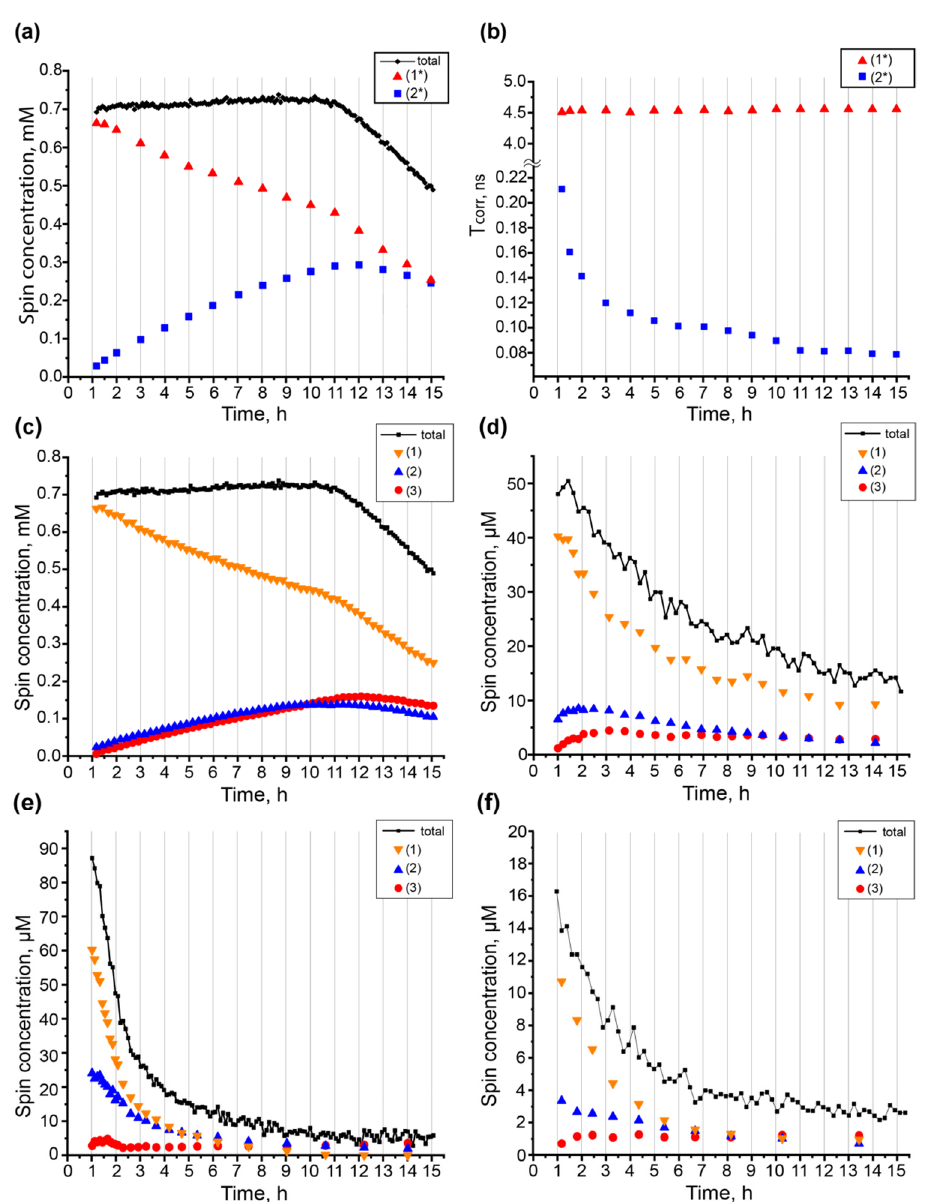
Figure 8. Second-integral decay kinetics and individual-component kinetics of the EPR spectra of A549 cells incubated with ( a , c ) 5.5 μ M, ( d ) 0.5 μ M sRL2 (molar ratio of spin label 1 to RL2 2 : 4) or with 1.34 μ M sRL2 (molar ratio of spin label 1 to RL2 2 : 3.5) without ( e ) or with ( f ) the addition of 1% of NaN 3 . ( b ) Time-dependent change of rotational correlation times for EPR spectral components in the case when simulations involve only two components. The time is counted from the end of the cell incubation with sRL2. Black: the total second integral of EPR spectra. ( a , b ) Red triangles and blue squares correspond to EPR spectral component 1* and component 2*. ( c – f ) Orange inverted triangles, blue triangles, and red circles correspond to EPR spectral component 1, component 2, and component 3, respectively. When the total spin concentration was low, the simulations were per- formed on the average set of the experimental EPR spectra to attain a better signal/noise ratio and hence better simulation. ( d ) Starting from the 7 th point, the simulation was performed on the set of 3, 5, and 7 EPR spectra. ( e ) Starting from the 12 th point, the simulation was performed on the set of 3, 5, 7, 9, 15, and 19 EPR spectra. ( f ) Starting from the 1 st point, the simulation was performed on the set of 3, 5, 7, 13, and 17 EPR spectra.